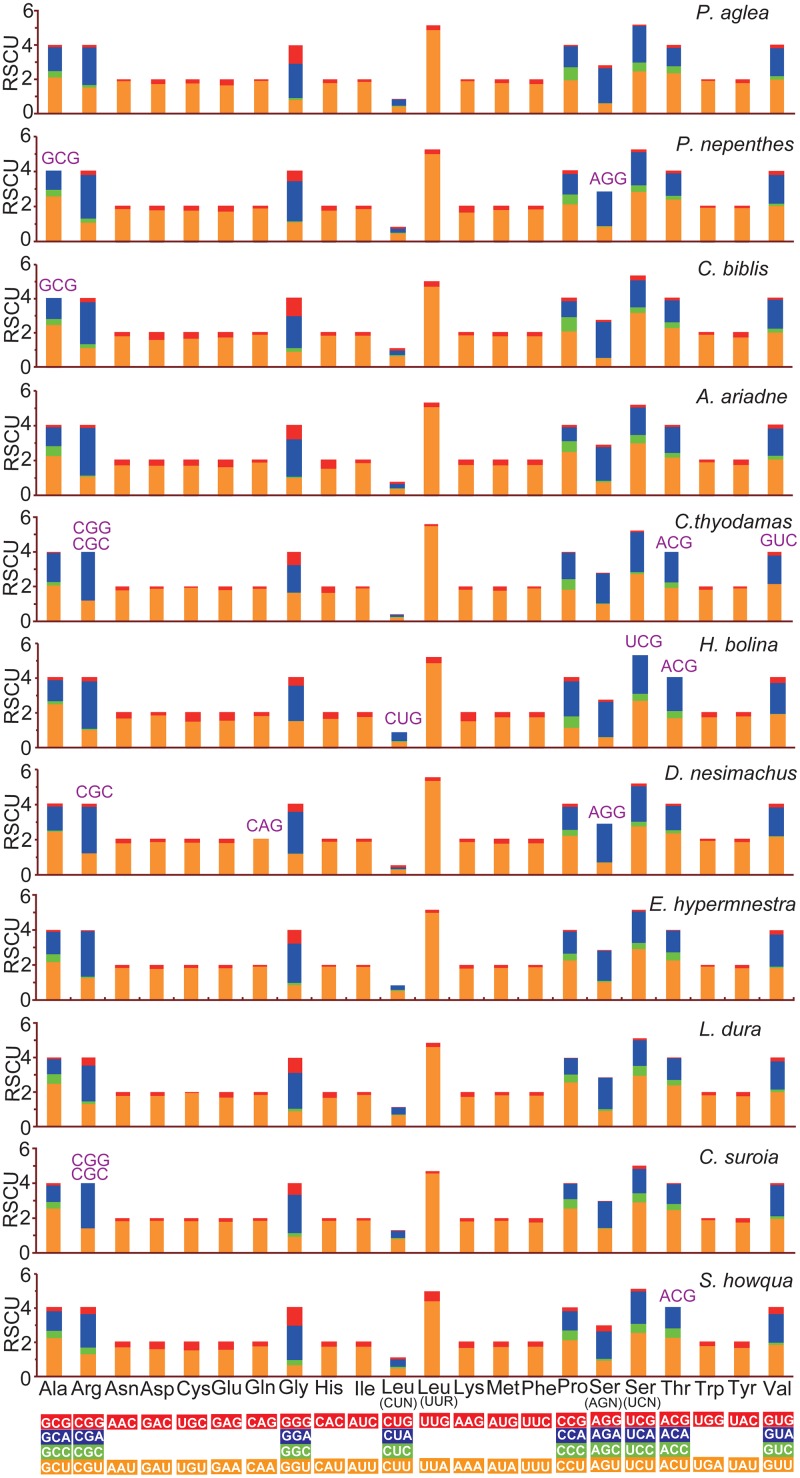
Relative synonymous codon usage (RSCU) in the eleven newly sequenced nymphalid mitogenomes.Codon families are given on the x axis. Codons that are not present in the genome are indicated in purple.